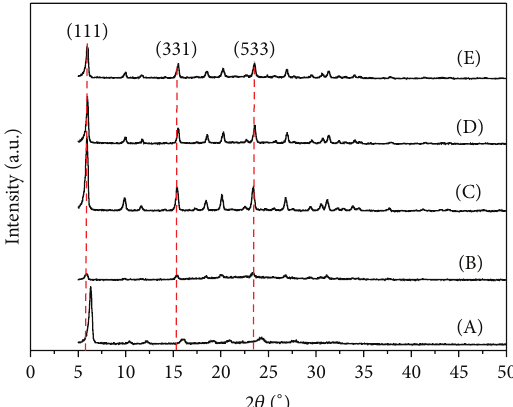
Figure 5: XRD patterns of the H-type zeolite samples. (A) HY-0-12; (B) HY-0.67-24; (C) HY-0.67-48; (D) HY-0.67-144; (E) HY-1.34-312.